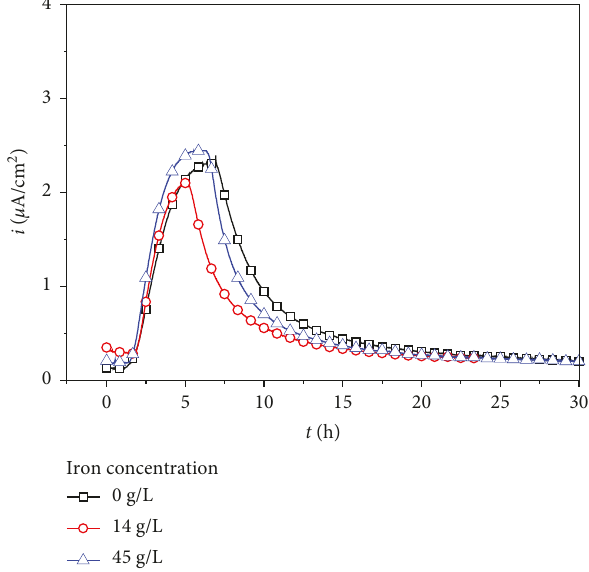
Figure 7: The influence of iron content of the HCl on the per- meation in steel S700.